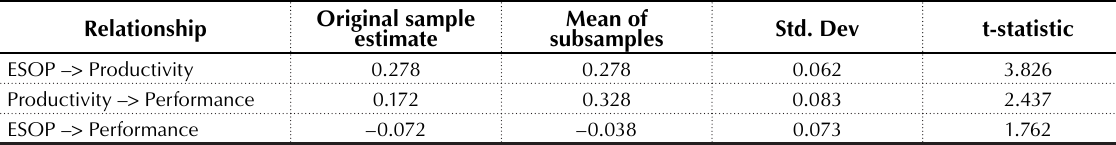
Table 2. Inner weights